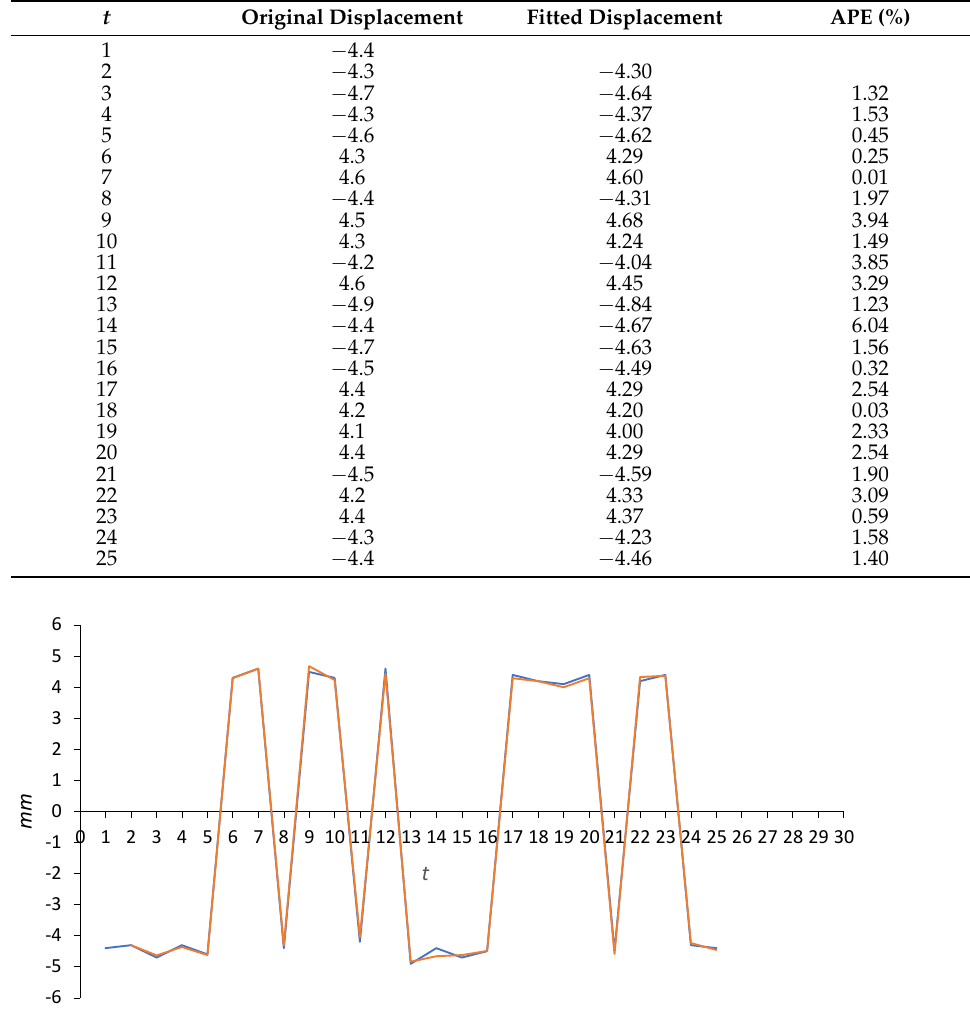
Table 15. Reconstructed displacements and absolute percentage errors.